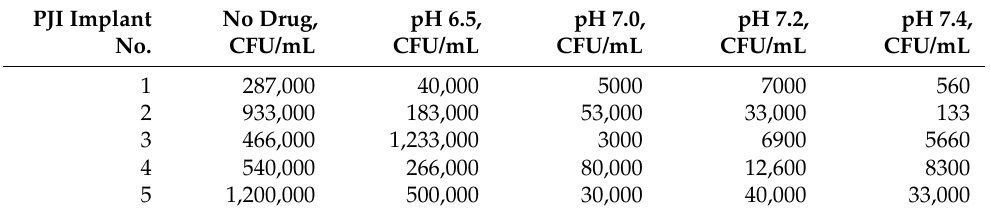
Table 3. Antibiofilm activity of PLG0206 (1.0 mg/mL) in dPBS at different pH levels against